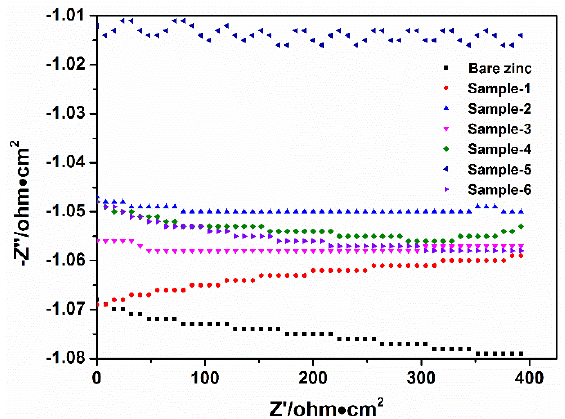
Figure 4. Open circuit potential (OCP) variation with time for samples immersed in a 3.5% NaCl solution at room temperature (25 °C).